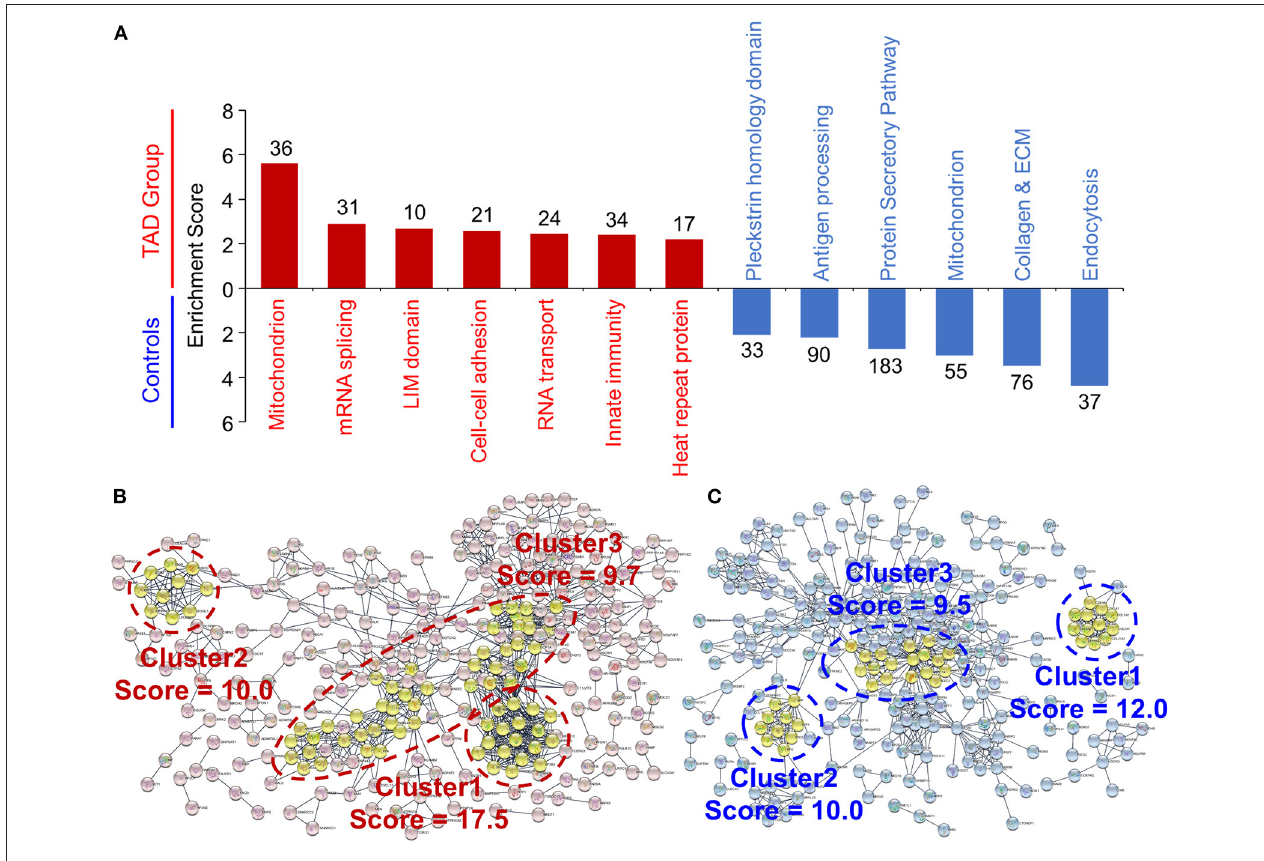
FIGURE 3 | Functional analysis of the differentially expressed proteins in TAD. (A) Functional annotation clustering of the differentially expressed proteins. The annotations were analyzed via the Database for Annotation, Visualization and Integrated Discovery (DAVID). All the proteins with an enrichment score over 2.0 are shown. The enriched protein counts of each annotation are provided. The results of the KEGG pathway and GO analyses are shown in Supplementary Figure 2 Protein–protein interaction networks of the upregulated proteins (B) and the downregulated proteins (C) in TAD samples. The networks were analyzed by STRING and visualized with Cytoscape software. The functional clusters were defined via the Molecular Complex DEtection (MCODE) plugin, and the top three clusters are